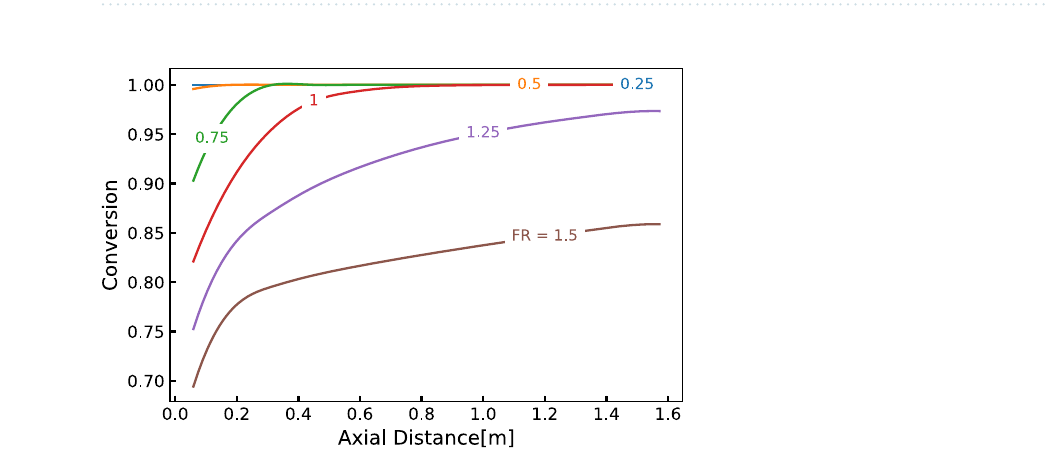
Figure 7. Contour plots of ceria mass fraction with different flow ratios for the flow set FS1. Images used courtesy of ANSYS, Inc.